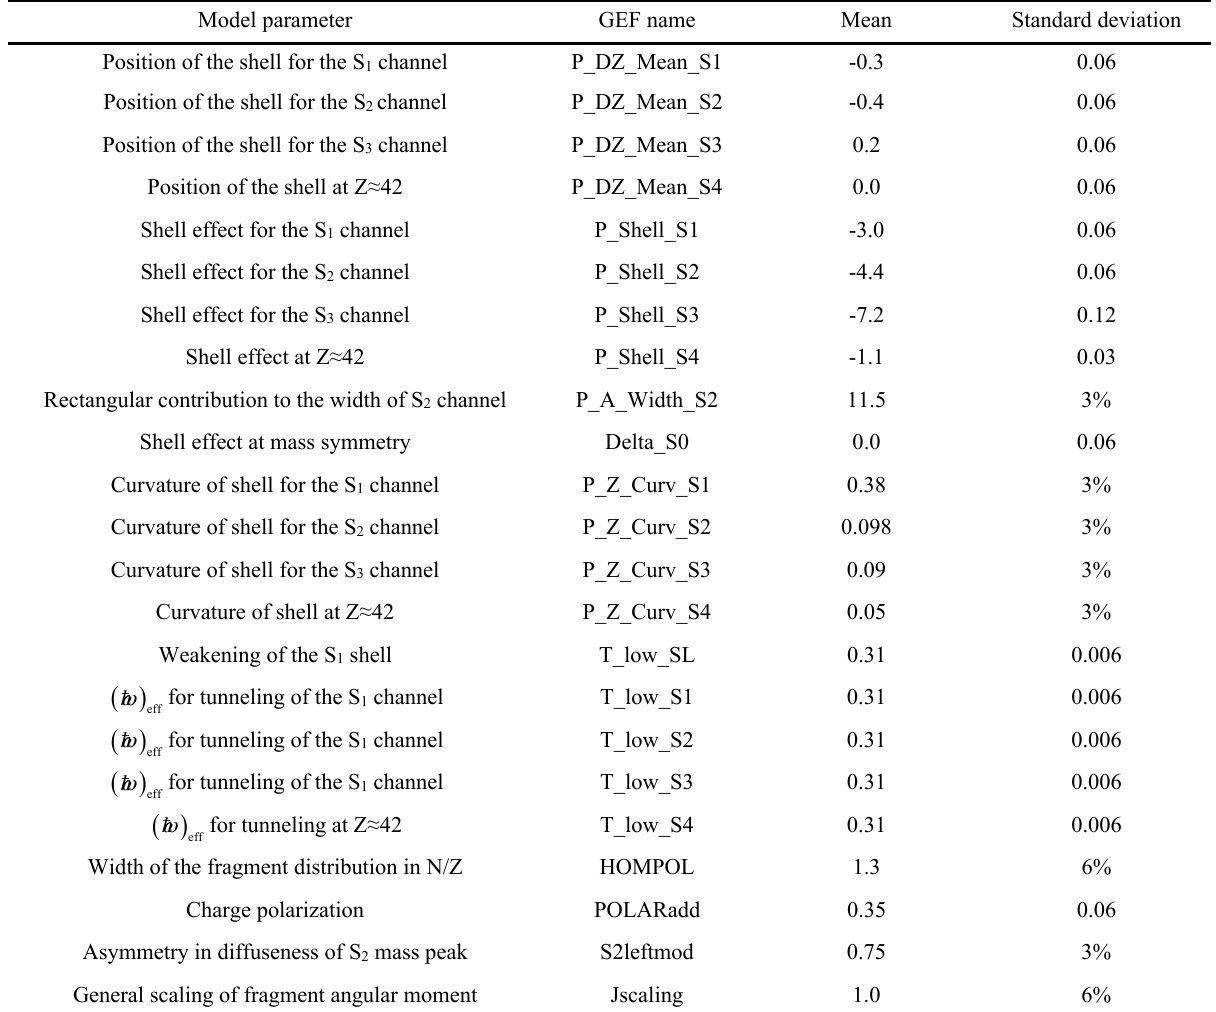
Table 1. Specific information on sampled model parameters in GEF2021.1.1